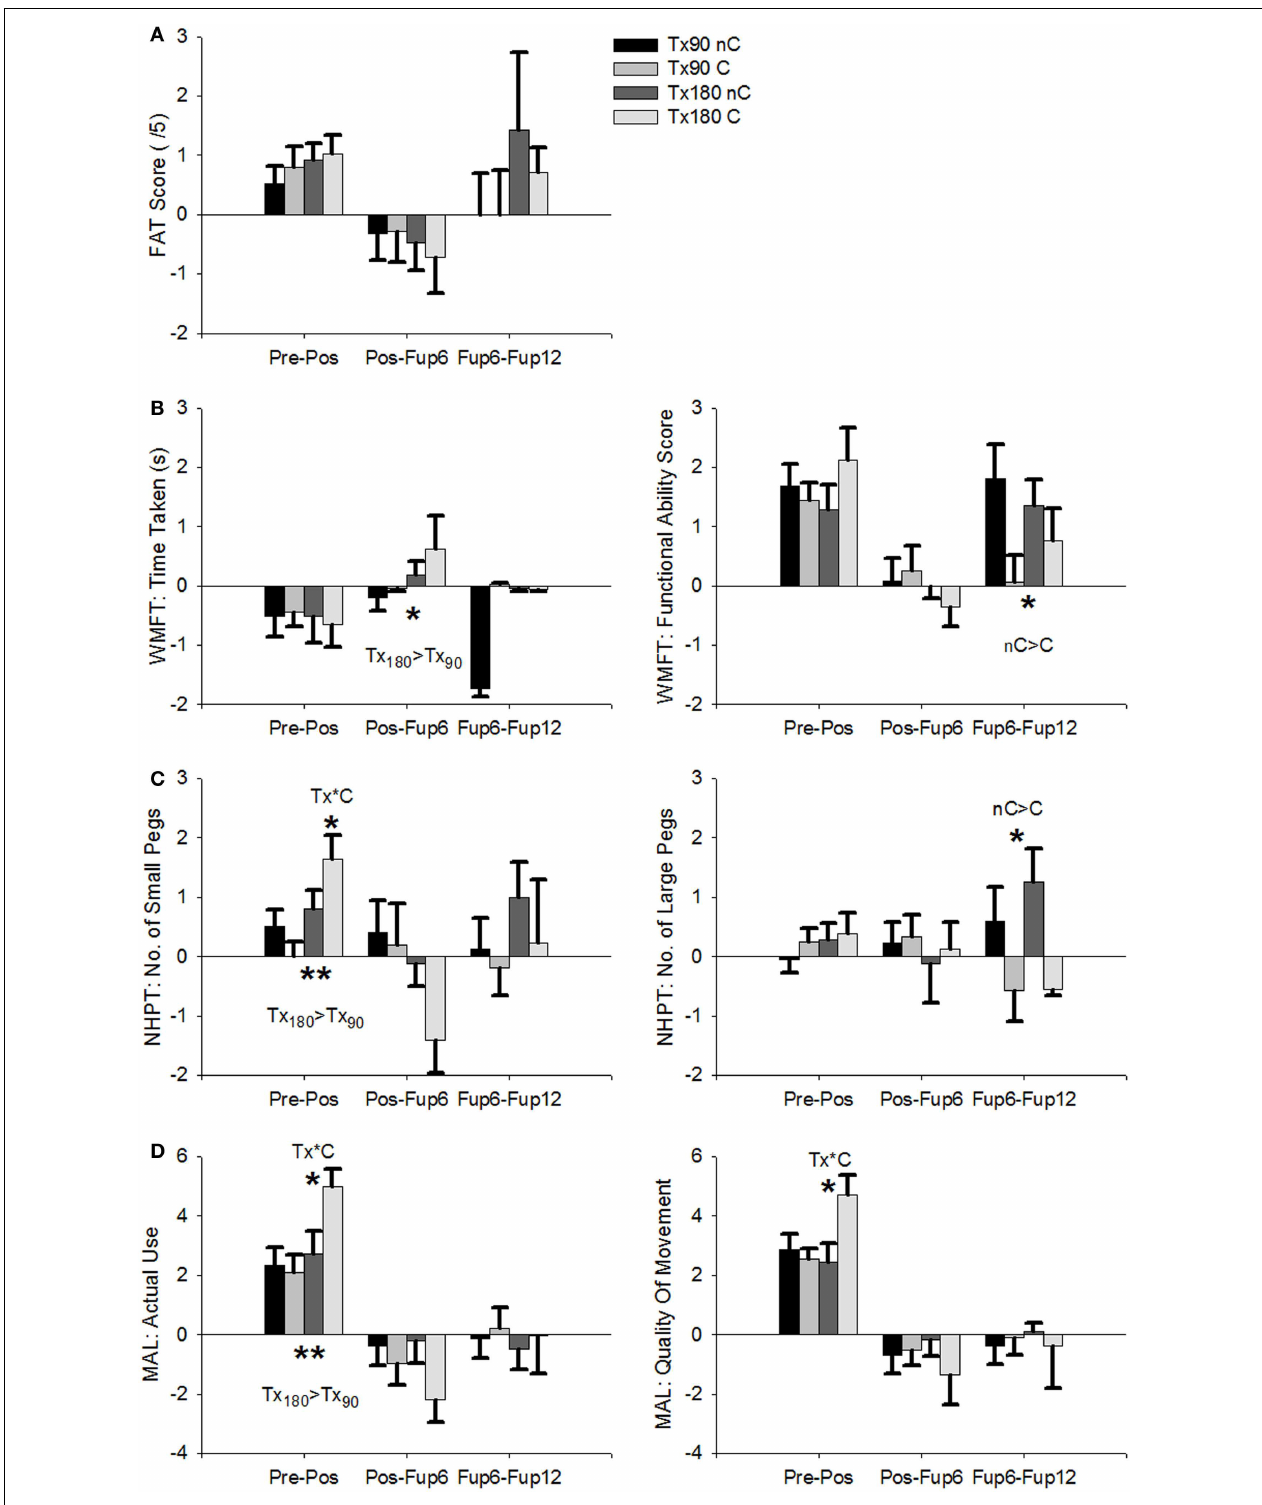
Test: number of small pegs (left) and large pegs (right). (D) Motor Activity Log: Amount of Use (left) and Quality of Movement (right). Error Bars are SEM. *** p < 0.001, ** p < 0.01, * p < 0.05. Probability values indicate an interaction of treatment or follow-up and either constraint (C) or training intensity